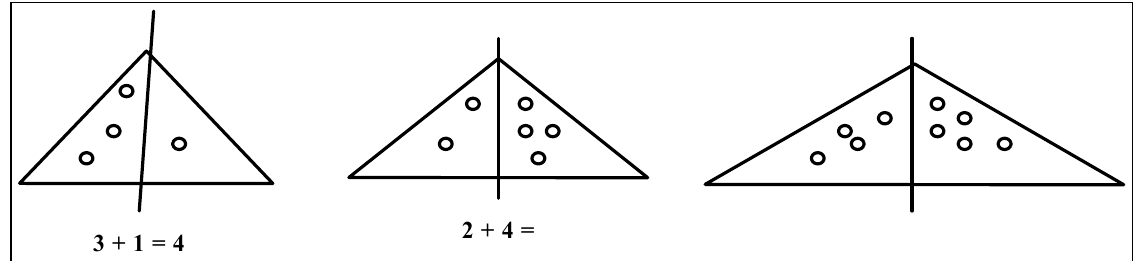
Figure 2 : Introduction of the equal sign in Classroom Mathematics